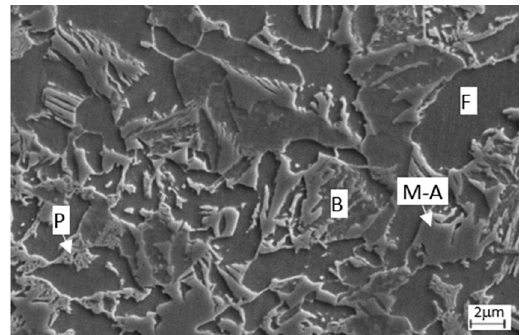
Figure 11. Heat treatment parameters: Soaking 850 °C/100 s, cooling rate 30 °C/s, bainitic hold 400 °C/600 s. Bainitic-ferritic microstructure with M-A constituent.